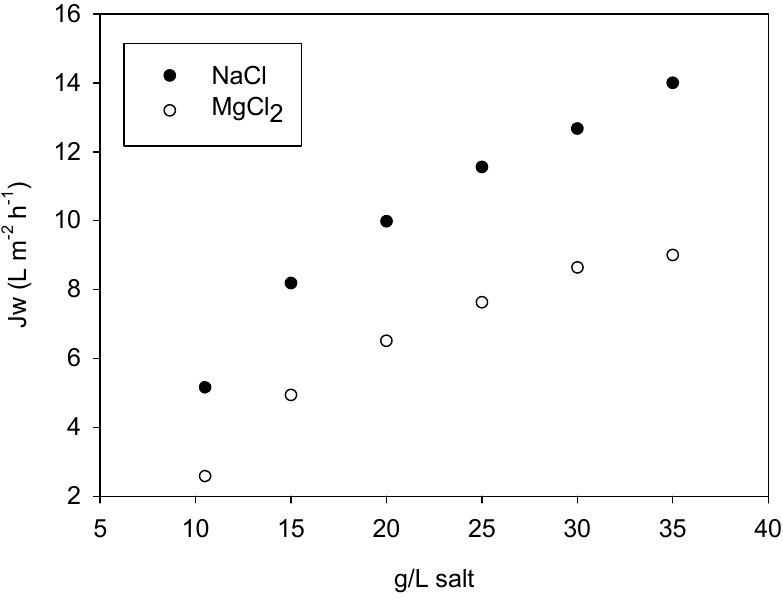
Figure 2. Water flux dependence on the draw solute concentration and the type of salt used.